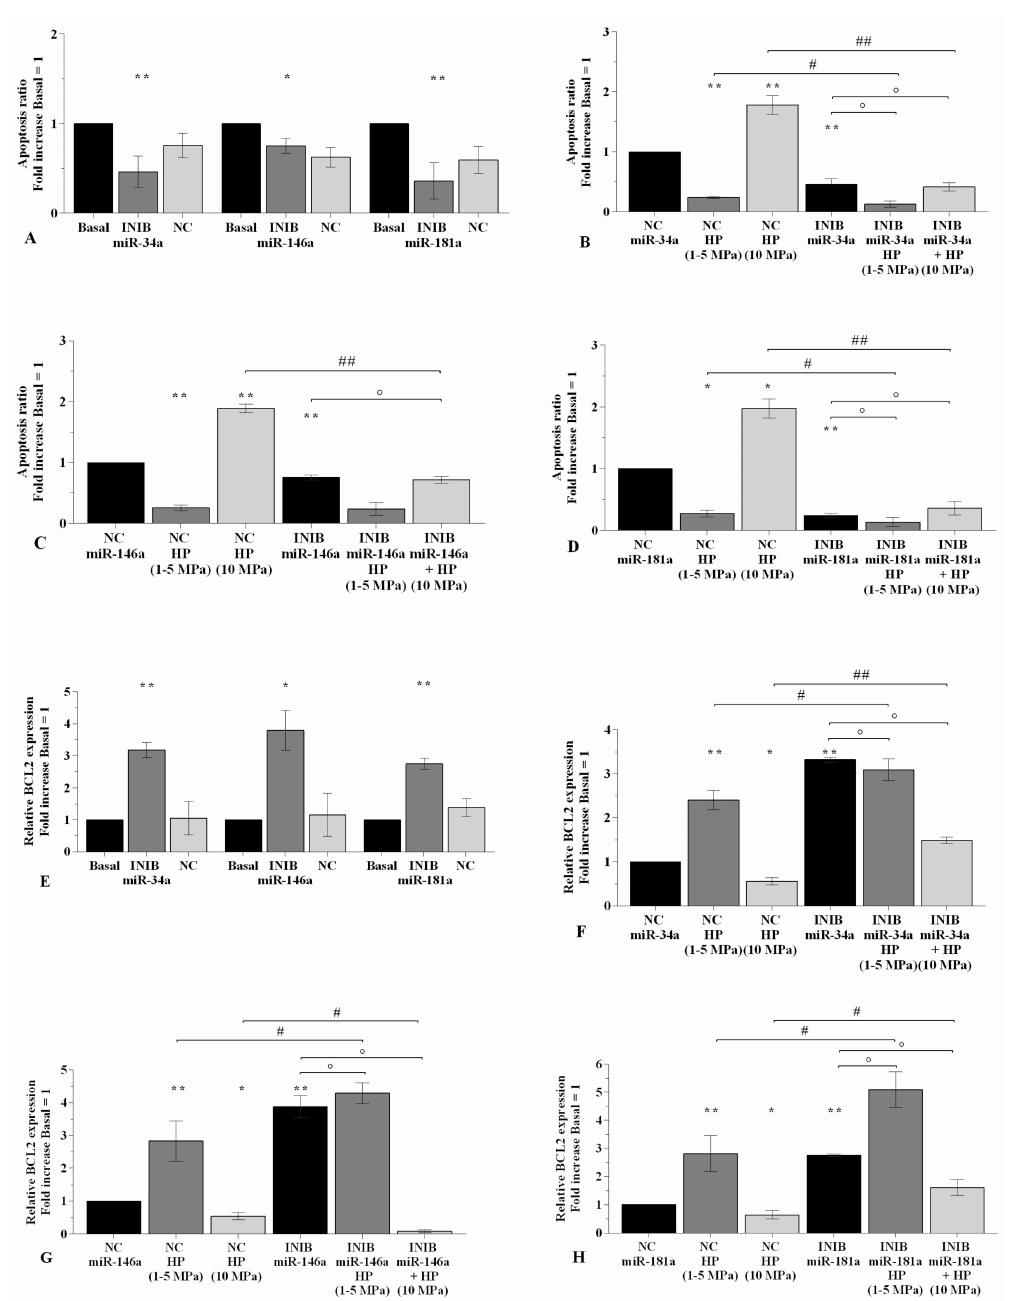
Figure 5. miRNA inhibition mediates HP e ff ect on apoptosis. ( A – D ) Apoptosis detection performed by flow cytometry analysis and measured with Annexin Alexa fluor 488 assay. Data were expressed as the percentage of positive cells for Annexin-V and propidium iodide (PI) staining. ( E – H ) Expression levels of BCL2 analyzed by real-time PCR. Human OA chondrocytes were evaluated at basal condition, after 24 h of transfection with miR-34a, miR-146a, and miR-181a inhibitors (50 nM) or NC (5 nM), and after 3 h of low sinusoidal (1 – 5 MPa) or static continuous (10 MPa) HP exposure. The ratio of apoptosis and the gene expression were referenced to the ratio of the value of interest and the value of basal condition or NC, reported equal to 1. Data were expressed as mean ± SD of triplicate values. * p < 0.05, ** p < 0.01 versus basal condition or NC. ◦ p < 0.05 versus inhibitor. # p < 0.05, ## p < 0.01 versus HP. INIB = Inhibitor, NC = negative control